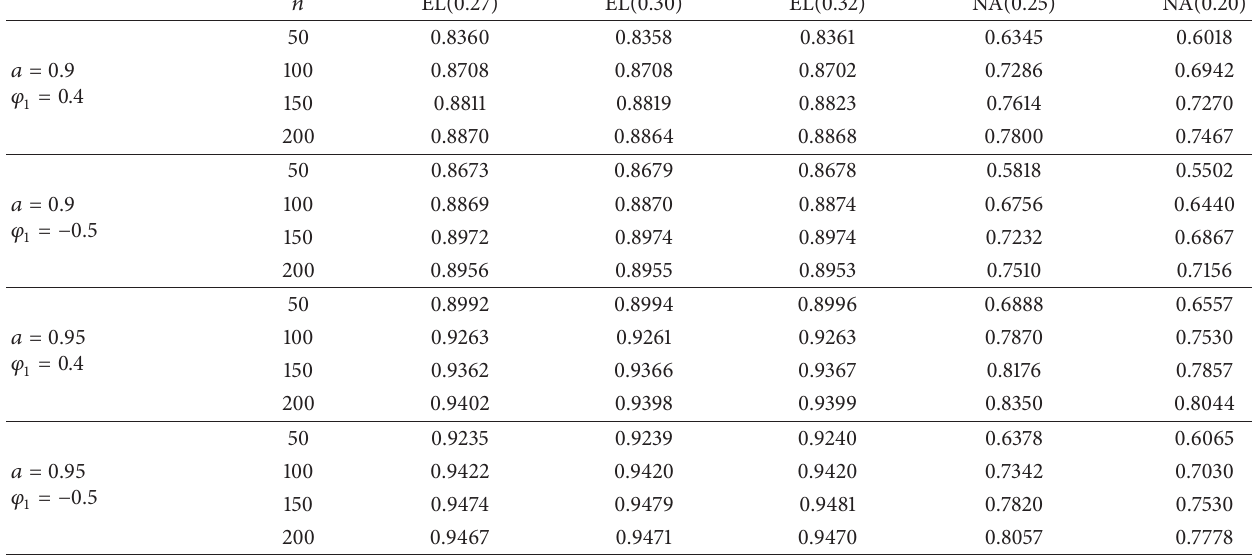
Table 3: The coverage probability of confidence intervals when 𝜀 𝑡 ∼ 𝐶𝑎𝑢𝑐ℎ𝑦